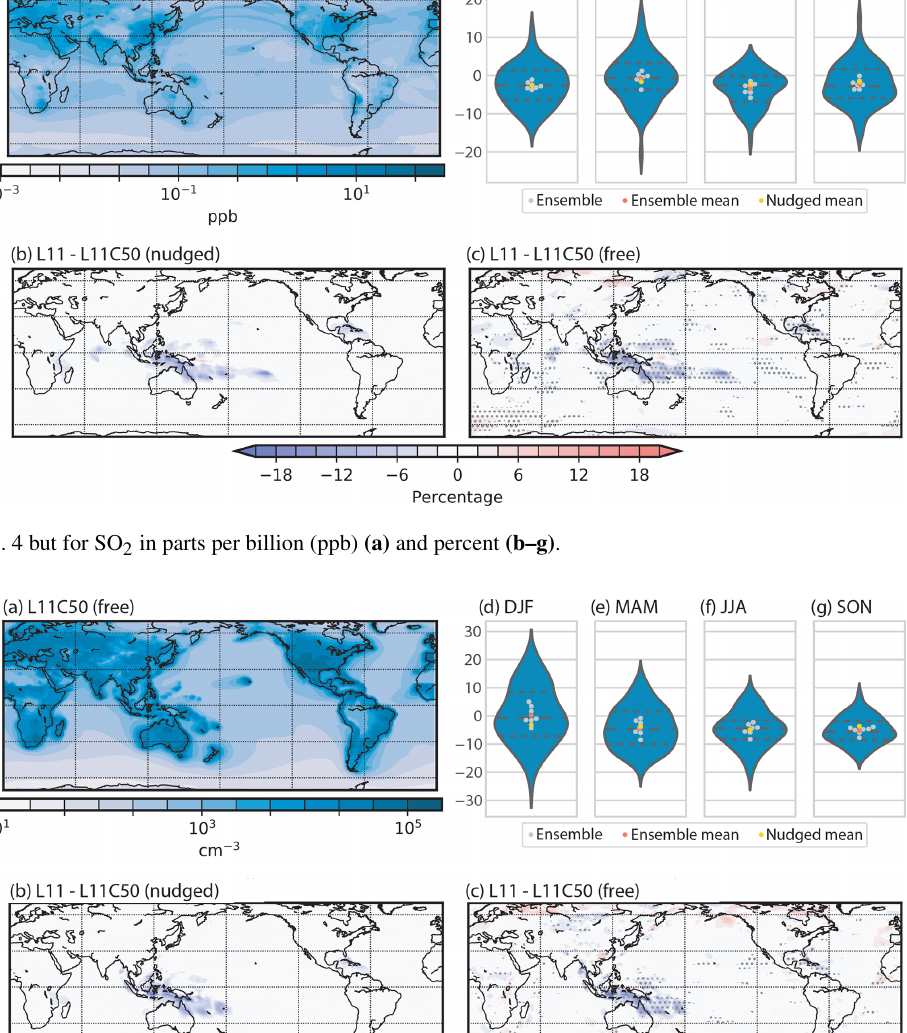
JJA ( p < 0 . 05) for the free-running ensemble (see Table